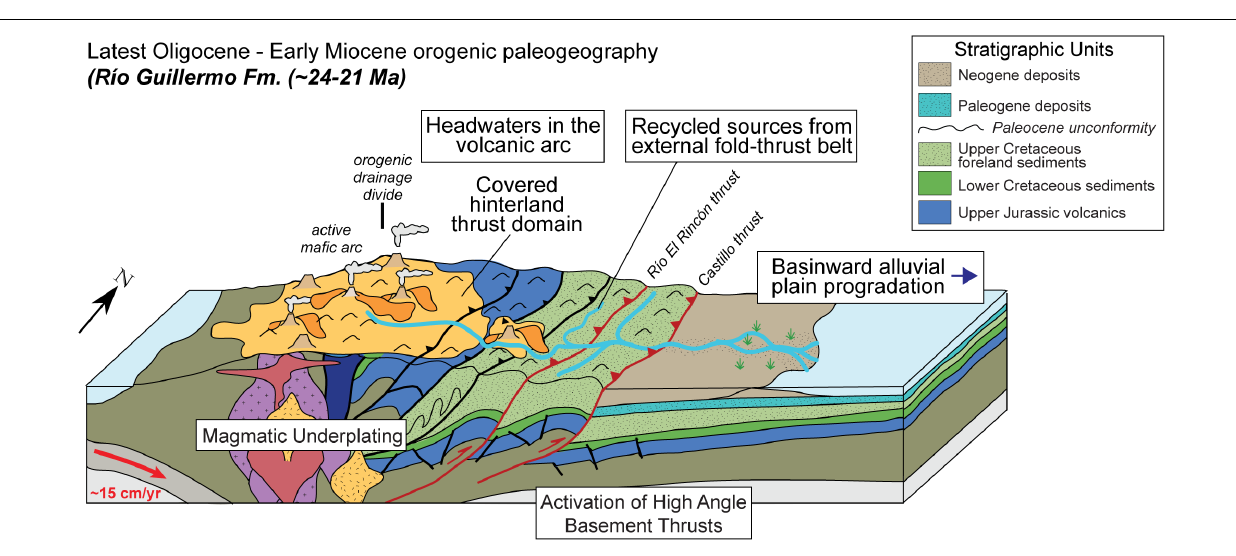
FIGURE 8 | Schematic paleogeographic cartoon of the late Oligocene – early Miocene orogenic configuration during deposition of the Río Guillermo Formation. Modified from Fosdick et al. (2015) with new learnings specifically to this time